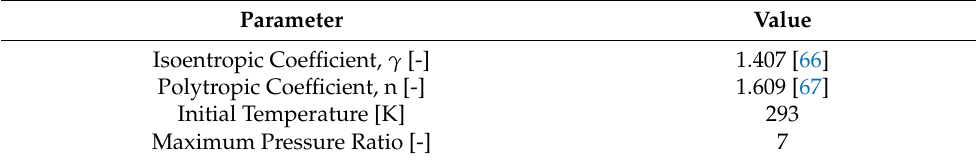
Table 3. Hydrogen Compression Boundary Conditions.